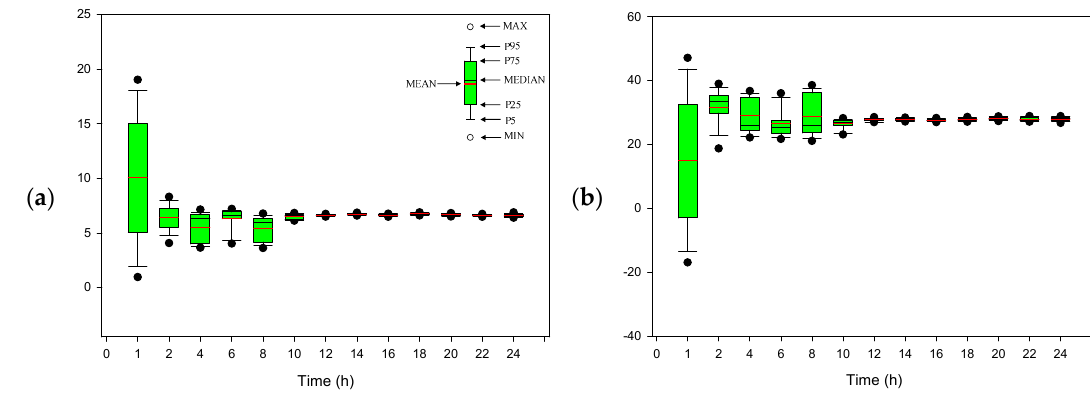
Figure 13. Initial ( a ) and updated ( b ) traffic noise prediction curves in scenario C.